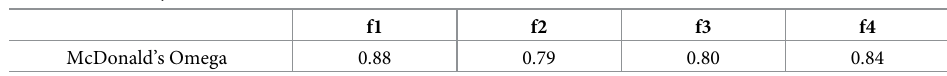
Table 3. Reliability indices for the four factors.